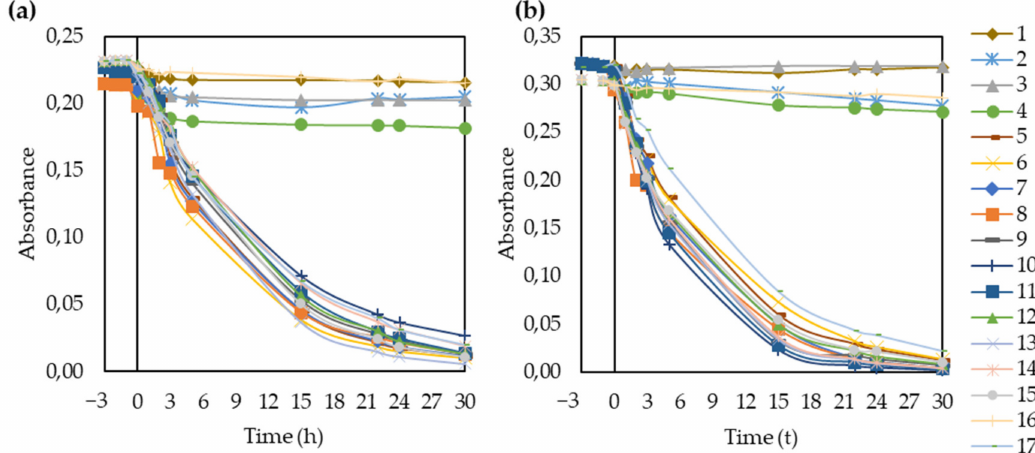
Figure 5. Absorbance of methyl orange for all fabricated membranes during adsorption and UV irradiation, under both ( a ) natural and ( b ) acidic (pH = 3)